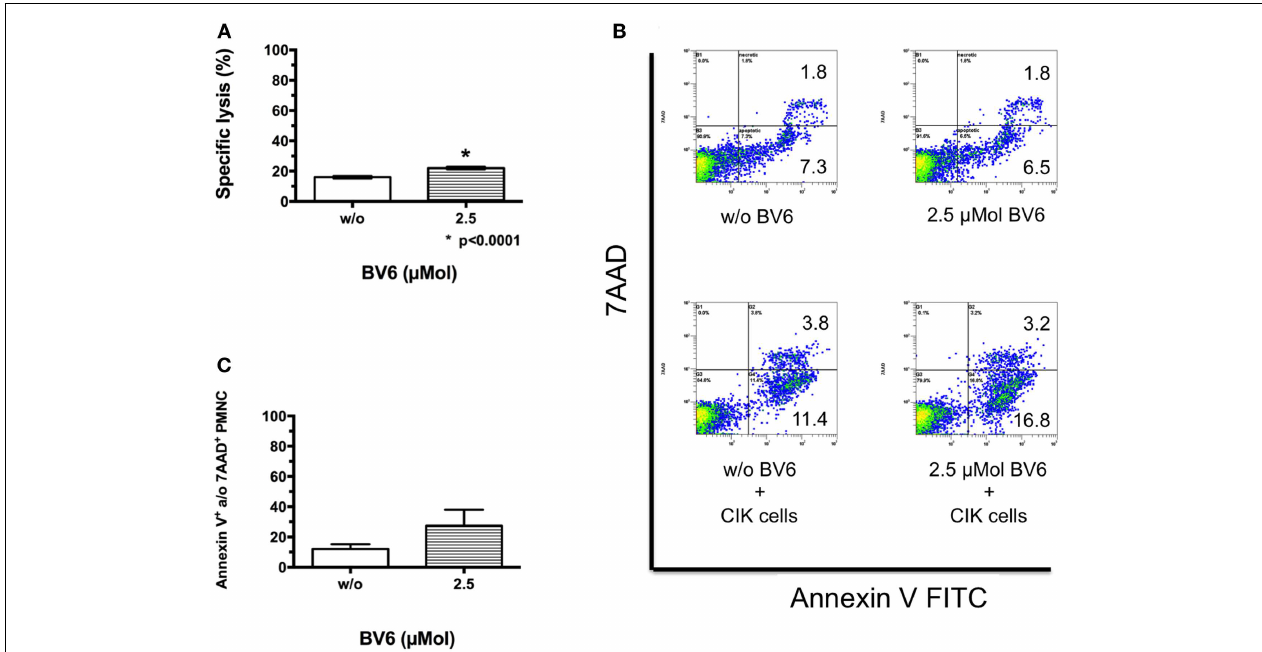
with CIK cells at an E:T ratio of 5:1 for 3h. For analysis of apoptotic and necrotic cells, cell suspensions were stained with AnnexinV FITC and 7AAD, respectively. PMNCs were further identified by forward scatter and excluding CD25-expressing larger CIK cells. One representative example showed that compared to untreated controls PMNCs were not affected by BV6, but by CIK cell treatment and furthermore by combination therapy (B) . Cytotoxicity data (AnnexinV- and/or 7AAD-positive PMNCs) from three independent experiments show as mean ± SEM indicated that BV6 and CIK cell treatment in combination was also toxic for normal cells (C)